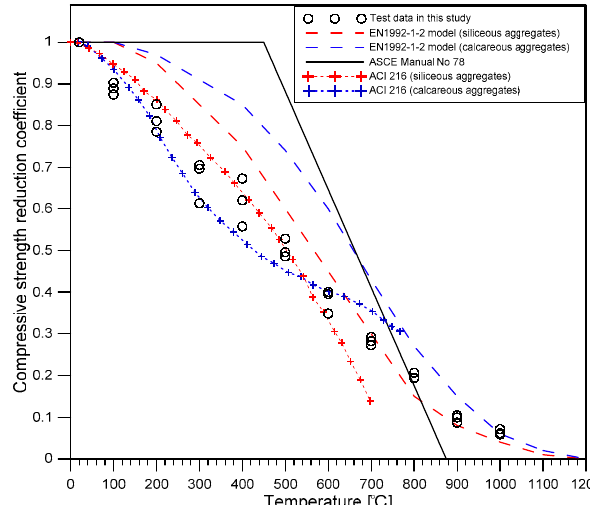
Figure 12. The relationship between static and dynamic elastic moduli of heat-damaged concrete.